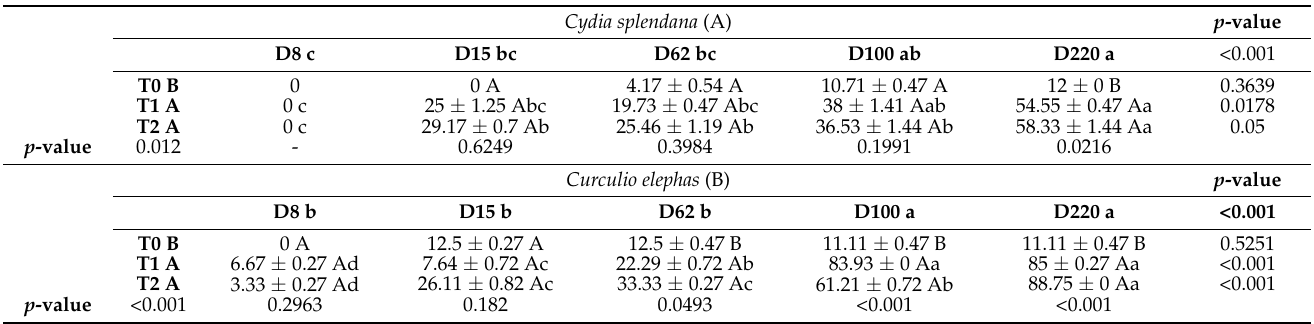
Table 1. Mortality percentage of chestnut moth, Cydia splendana (Hübner), (A) and chestnut weevil, Curculio elephas (Gyllenhal) (B) larvae in different modalities on days 08, 15, 62, 100 and 220 after treatment. Insect mortality was corrected for the control treatment (natural mortality) using the Schneider-Orelli formula.